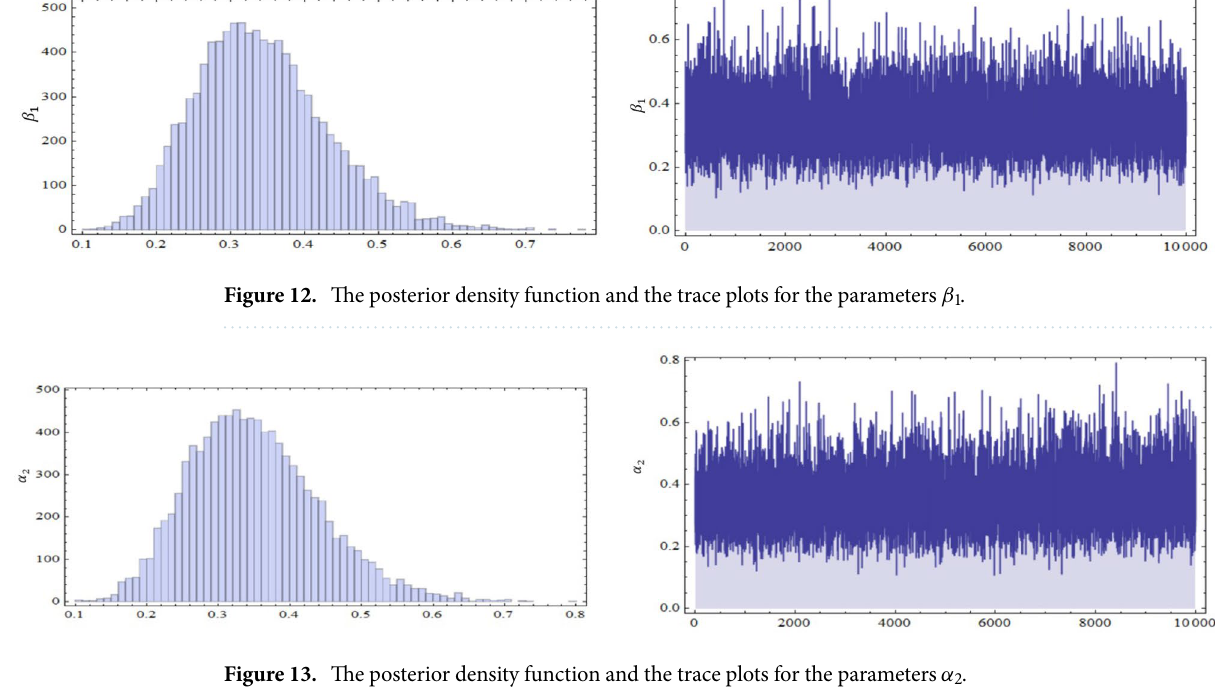
Figure 13. The posterior density function and the trace plots for the parameters α 2 .